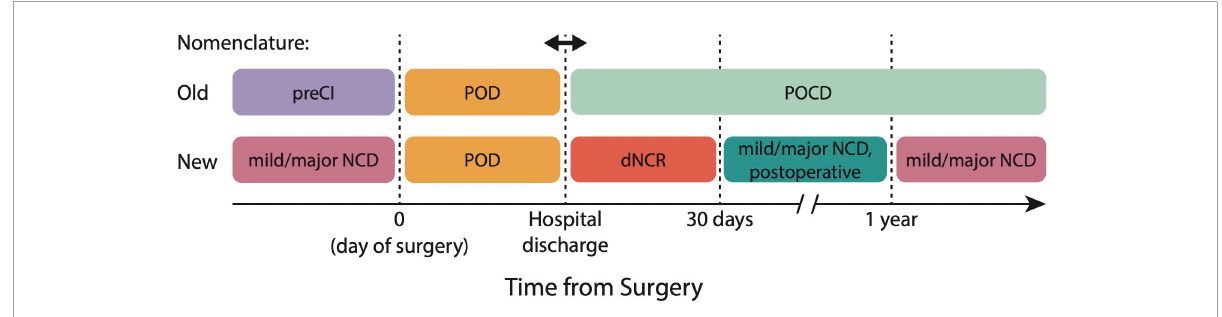
FIGURE1 2018 nomenclature for perioperative neurocognitive disorder (PND) classification. The new nomenclature aligns PND definitions with Diagnostic and Statistical Manual-5 (DSM-5) definitions of PND, and reclassifies former conditions of PreCI, POD, and POCD. dNCR, delayed neurocognitive recovery; NCD, neurocognitive disorder; POCD, postoperative cognitive dysfunction; POD, postoperative delirium; PreCI, pre-existing cognitive impairment.